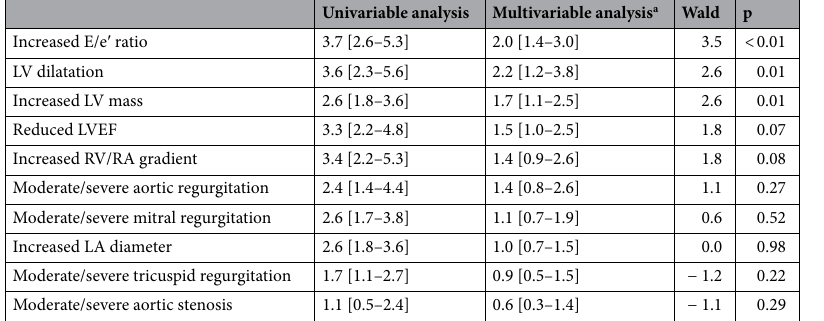
Table 4. Hazard ratio [95% confidence interval] for cardiovascular mortality based on presence or absence of echocardiographic abnormalities in patients with PVCs during recovery, n = 1327 (138 events). LA left atrial, LV left ventricle/ventricular, LVEF LV ejection fraction. a Hypertension, diabetes, ischemic heart disease, heart failure, body-mass index, use of either betablocker, angiotension-converting enzyme inhibitor, angiotension II blockers, loop diuretics, antihrombotics, anti-coagulants, or calcium channel